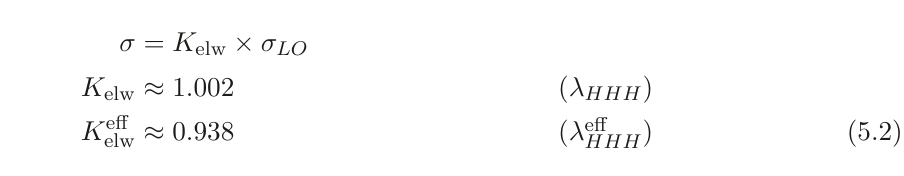
JHEP10(2022)185